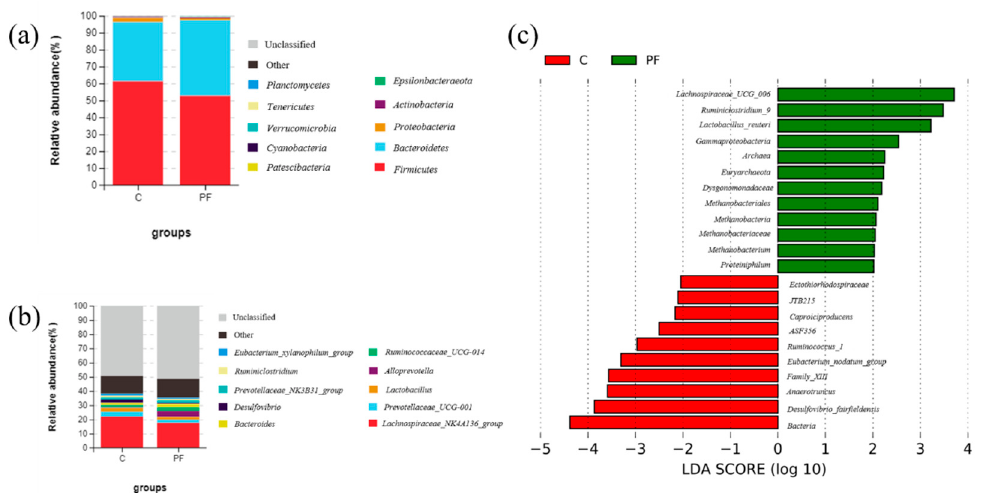
Figure 5. Relative abundance distribution of the 10 most abundant microbial taxa at the phylum level ( a ) and genus level ( b ). ( c ) LEfSe score plot of the discriminative microbial taxa (LDA score > 2) that are highly enriched in the C and PF